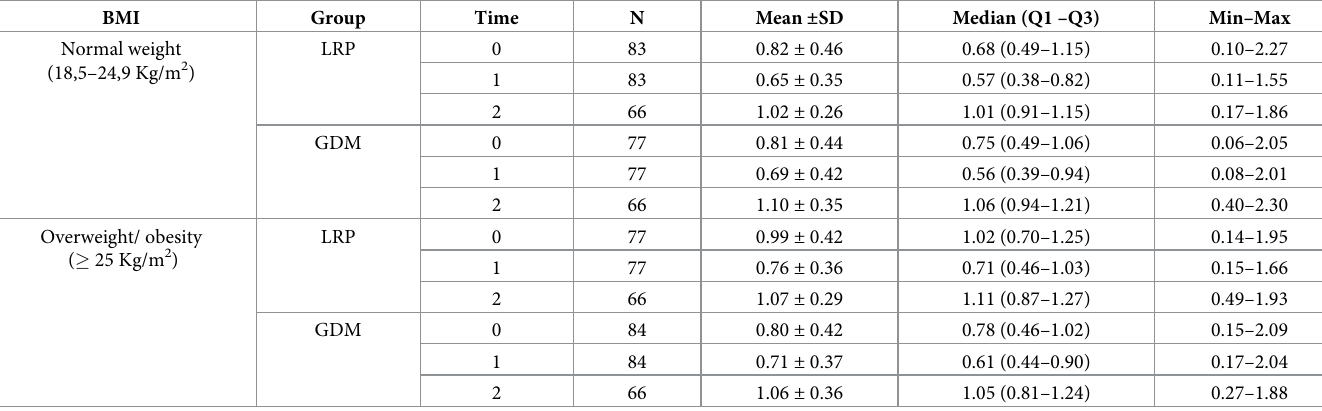
Table 2. Distribution of metabolic equivalent (MET) at each time point in the different groups according to body mass index category (N = 321). BMI